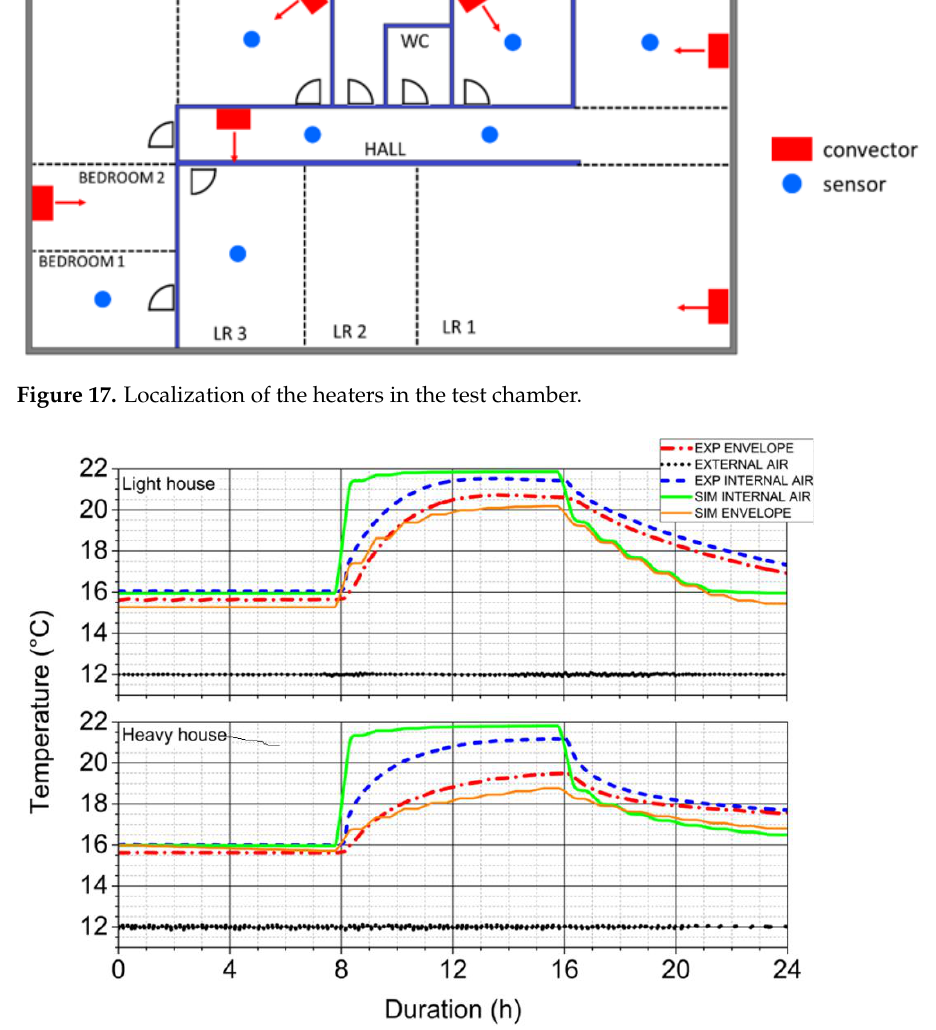
Figure 18. Temperature evolution in the test chamber (upper: light mass envelope, bottom: heavy mass envelope).